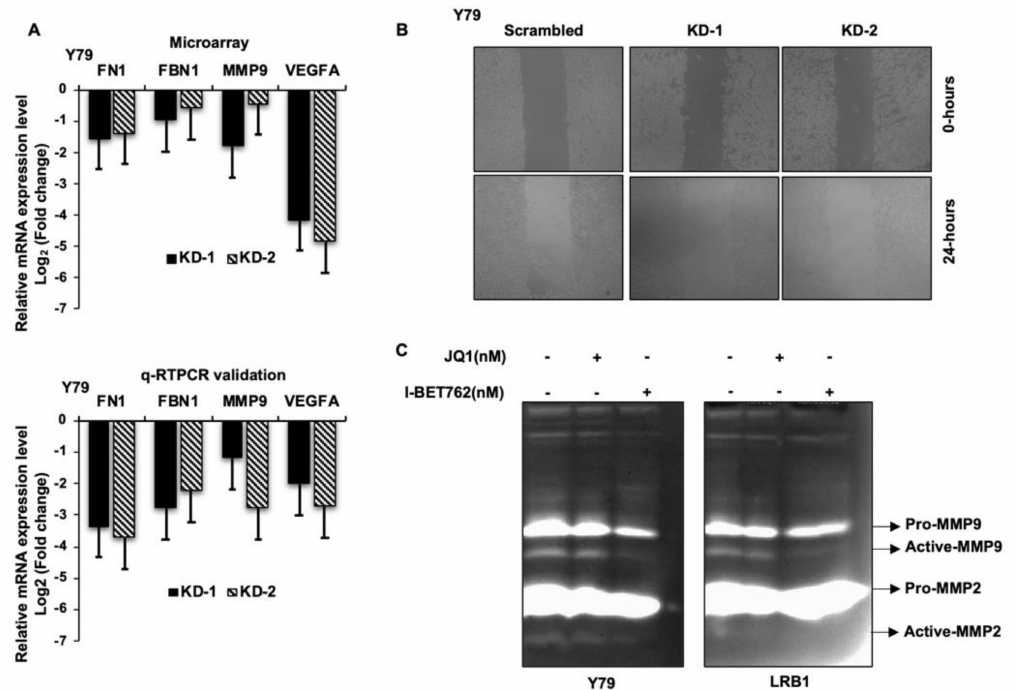
Figure 7. The effects of MYCN inhibition on cell migration in RB cells. ( A ) The bar graphs represent the top 4 downregulated genes involved in cellular migration and metastasis, upon MYCN knockdown in Y79 cells identified by microarray analysis (upper panel) and qRT-PCR validation of the identified genes (lower panel). ( B ) Reduced migration of cells was observed upon MYCN knockdown compared to the scrambled control cells. ( C ) Decreased gelatinolytic activity of active-MMP9 was observed in RB cells following MYCN inhibition. The error bars represent the standard error of